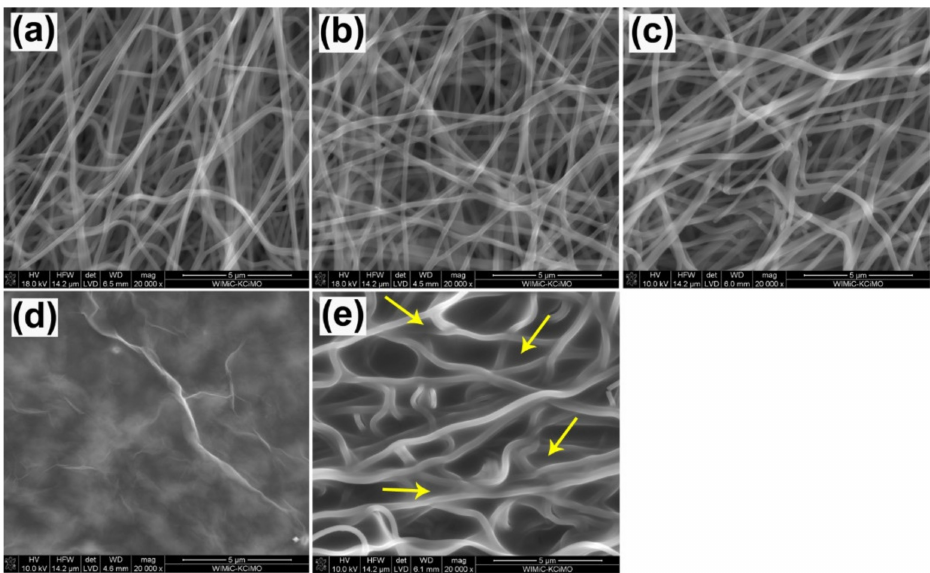
Figure 1. SEM microphotograph of CNFs before ( a ) and after surface modification in HNO 3 ( b ), in sodium hyaluronate ( c ), using GO ( d ) and using silica oxycarbide ( e